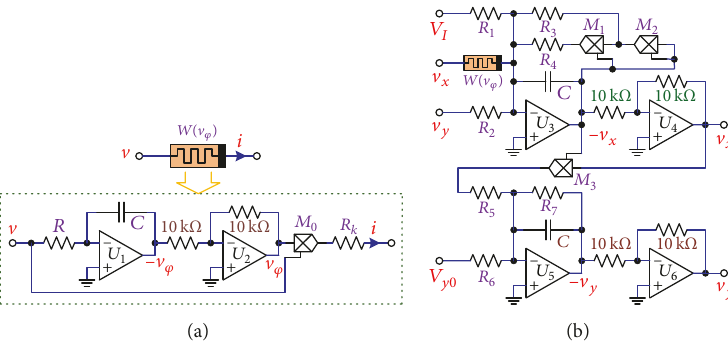
Figure 9: Physical electronic circuit implementation for the memristive HR neuron model. (a) Implementation circuit of the flux-controlled ideal memristor. (b) Main circuit of the memristive HR neuron model.